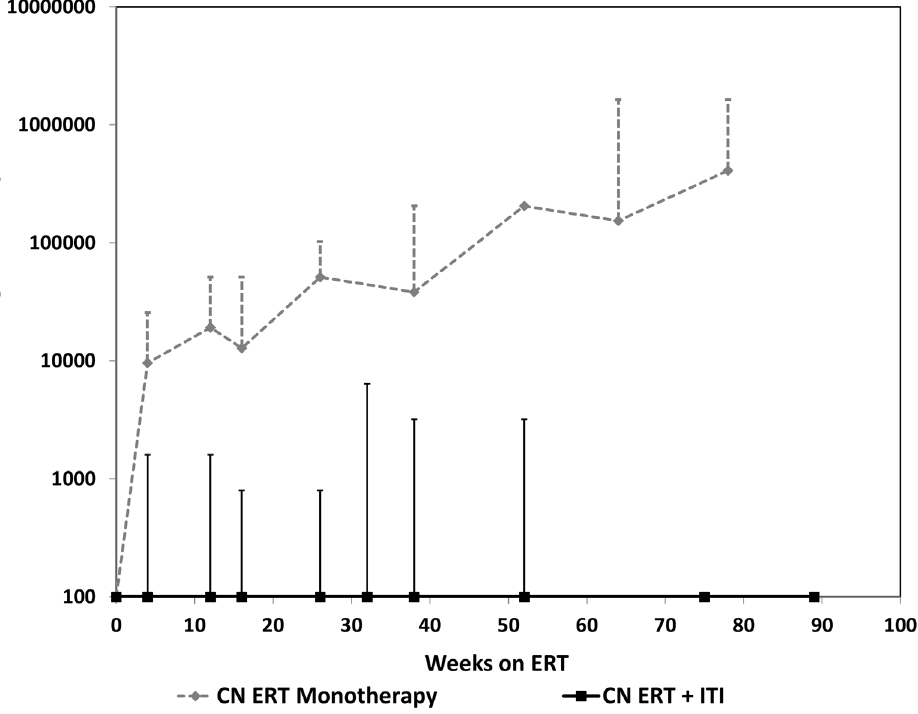
Figure 6. Comparison of anti-rhGAA IgG antibody titers seen over time in CRIM-negative (CN) treated with ERT monotherapy (n=8) versus CN ERT + ITI (n=7) treated patients.